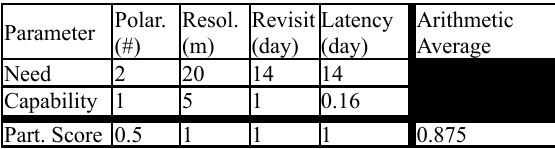
Table 4. Example estimation of percent capabilities addressing the desired needs for parameters defined in the SATM (GO E9).